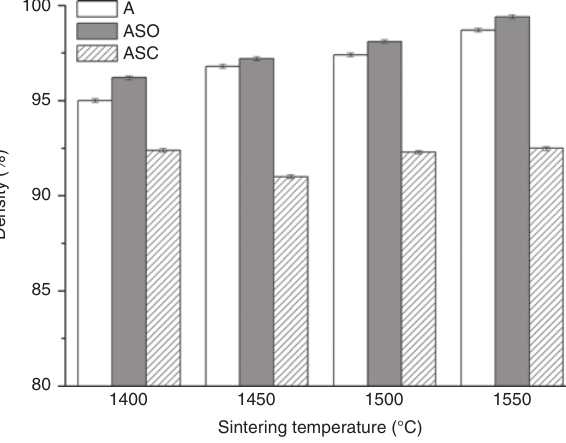
Figure 2: Graph of density as a function of sintering